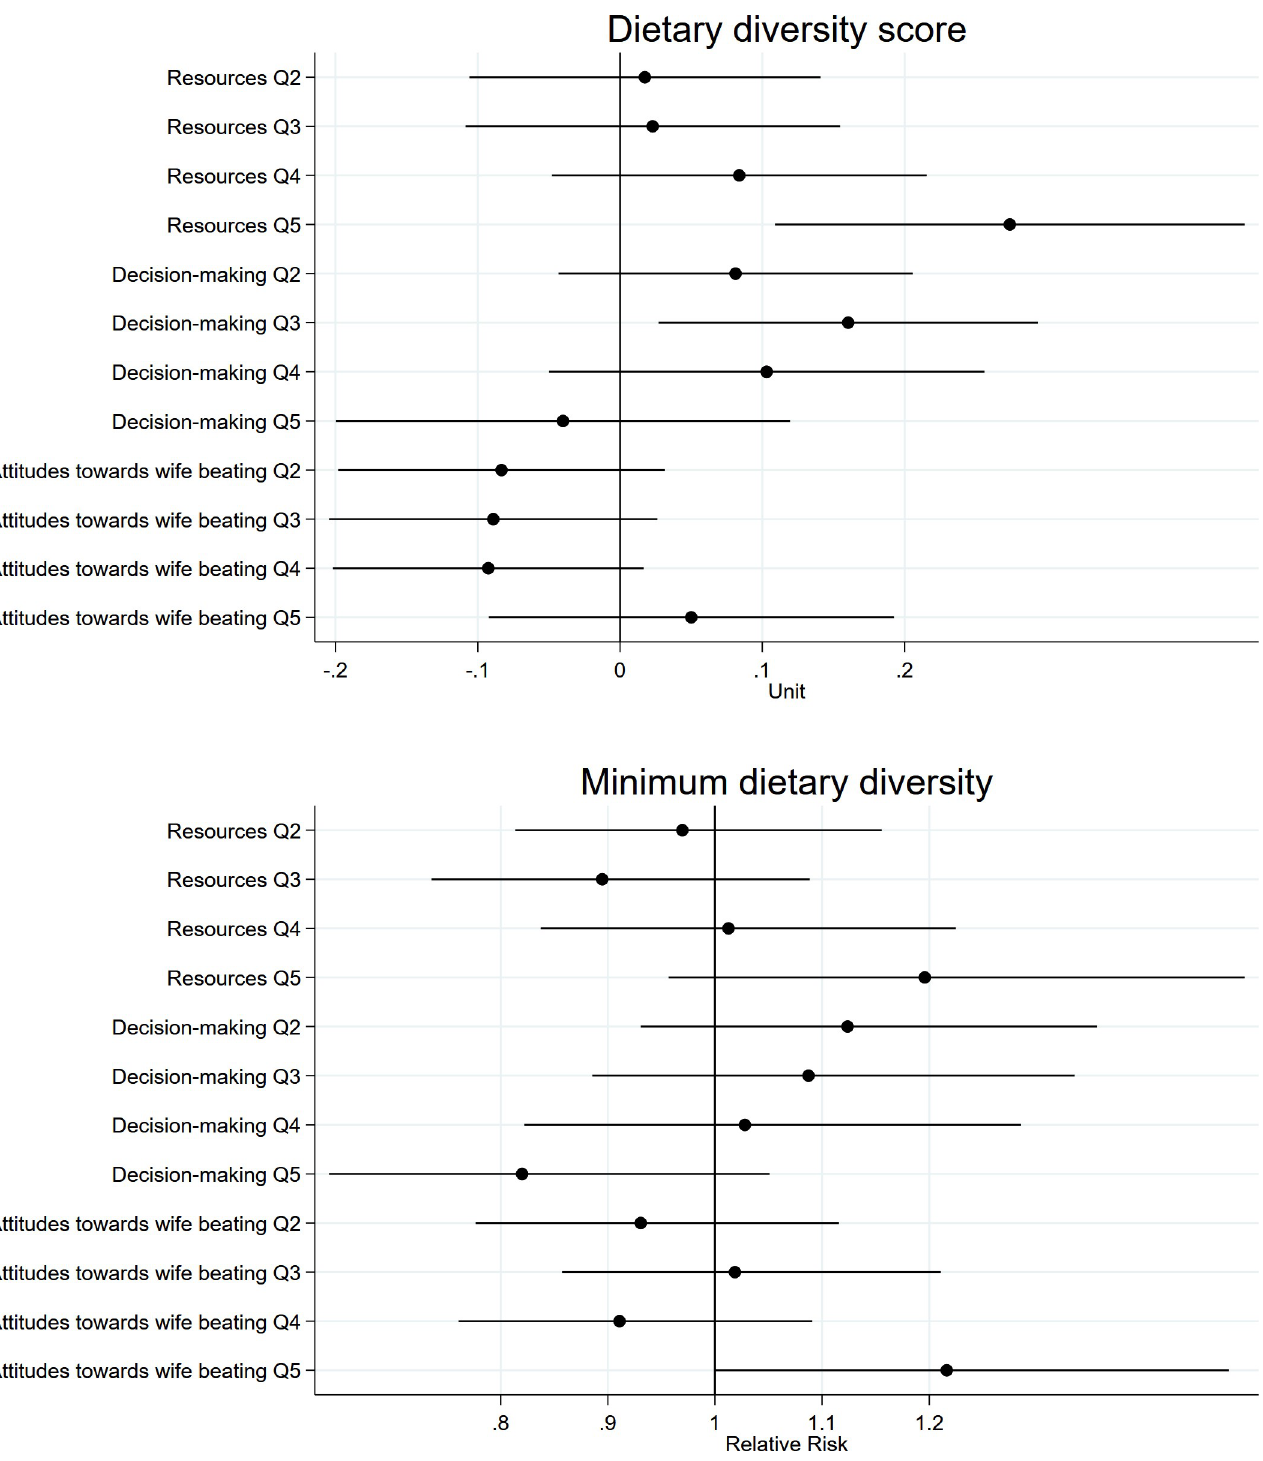
Fig 6. Associations between quintile categories of women’s empowerment dimensions and child nutrition outcomes. All estimates accounted for clustering and representativeness using country-specific cluster variables and sampling weights and controlled for household wealth, rurality, and size; household head’s age and sex; maternal education, age, and age at first cohabitation; child age and sex; and country and survey year. Reference quintile category is Q1, lowest. Q, quintile category.